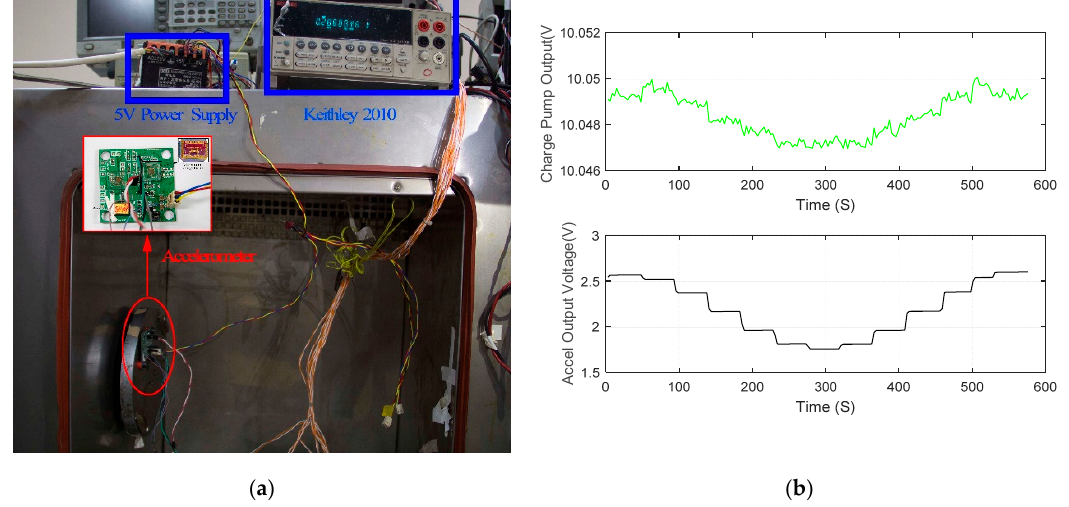
Figure 9. The relation between scale factor and the inversion of (cid:1848) (cid:3004)(cid:3017)(cid:2870) − 2(cid:1848) (cid:3014) (cid:1848) (cid:3004)(cid:3017) : For accelerometer S6401 and (cid:1848) (cid:3014) = 2.5 (cid:1848) , the fitting function is (cid:1877) = 20.9392(cid:1876) + 0.0013 ; For accelerometer S6407 and (cid:1848) (cid:3014) = 2.5 (cid:1848) , the fitting function is (cid:1877) = 21.7927(cid:1876) − 0.0026 ; For accelerometer S6410 and (cid:1848) (cid:3014) = 1.25 (cid:1848) , the fitting function is (cid:1877) = 23.6883(cid:1876) − 0.0471 .